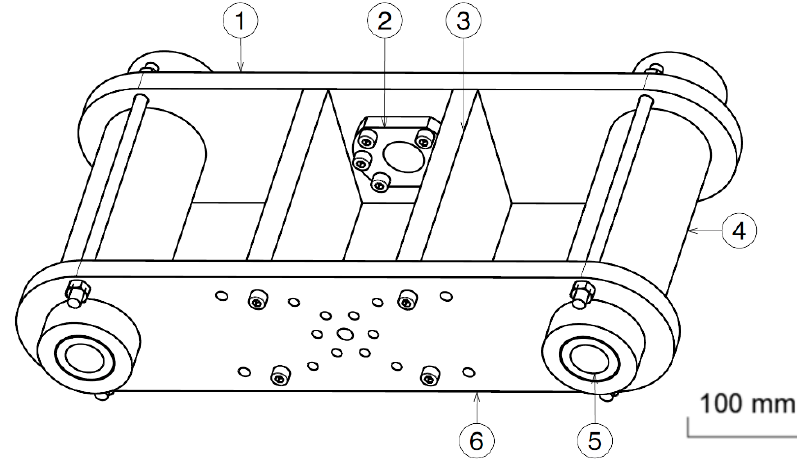
Figure 7. Crosshead drawing: (1) anterior plate; (2) nut; (3) reinforcement plate; (4) hollow bar; (5) ball bearing; (6) posterior plate.